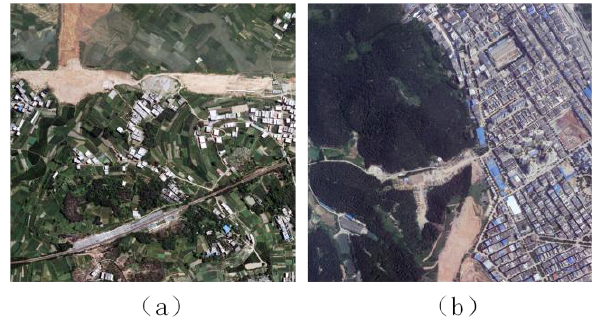
Figure 6. Triangulation of dataset 1 before and after merging. (a) Figure 4. Corresponding orthophotos of the two datasets. (a) Triangulation of dataset 1 before merging; (b) Enlarged subsets dataset 1, (b) dataset 2. of dataset 1 before merging; (c) Triangulation of dataset 1 after merging; (d) Enlarged subsets of dataset 1 after